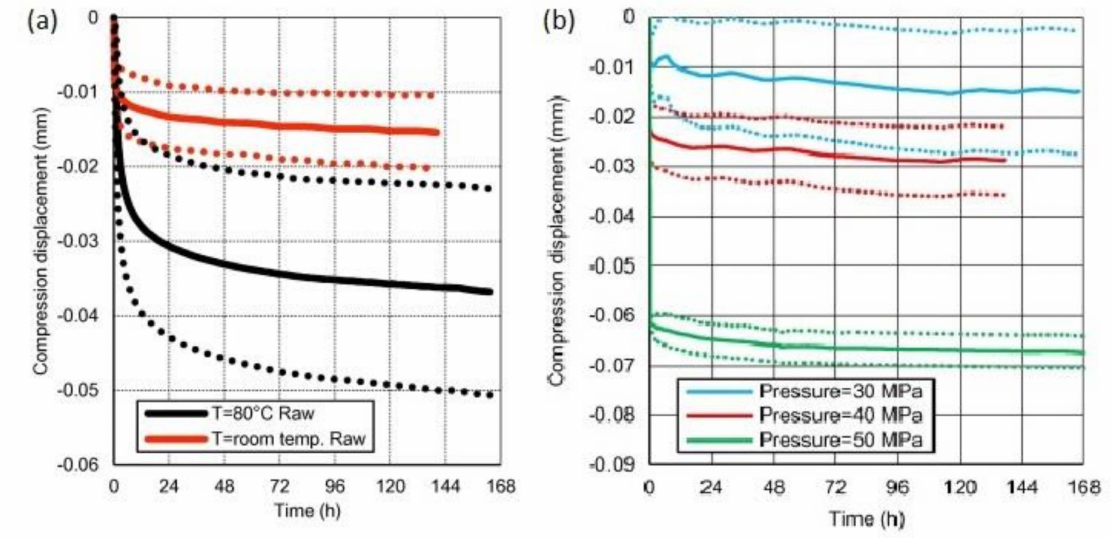
Figure 5. Through-the-thickness compression displacement in carbon / epoxy composite with time: ( a ) influence of temperature at pressure of 40 MPa, ( b ) influence of pressure at 25 ◦ C temperature